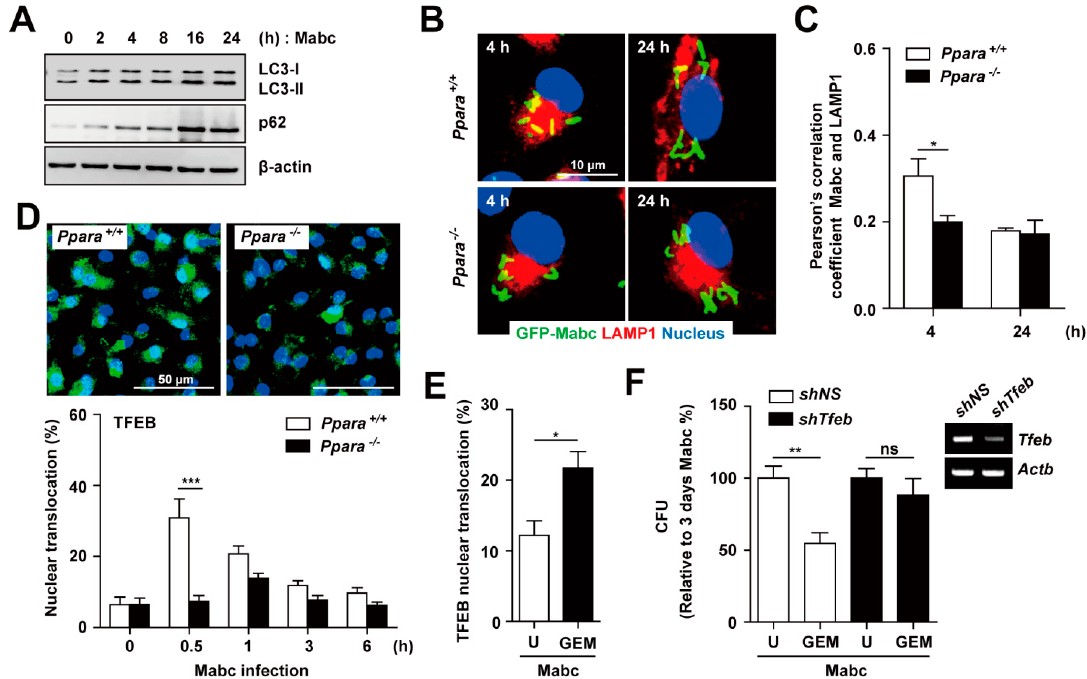
Figure 6. PPAR α activation by GEM enhances TFEB-mediated antimicrobial activity. ( A ) BMDMs were infected with Mabc (MOI of 5) for the indicated times, and the p62, LC3, and β -actin protein levels were evaluated by immunoblotting ( B ) BMDMs were infected with GFP-Mabc (MOI of 5) for 4 or 24 h. Alexa-594-conjuated LAMP1 (red) and DAPI (nuclei; blue) were visualized by confocal microscopy. Scale bars, 10 µ m. ( C ) GFP-Mabc and LAMP1 colocalization was assessed by calculating Pearson’s correlation coe ffi cient. ( D ) Ppara +/+ and Ppara - / - BMDMs were infected with Mabc (MOI of 5) for the indicated times, and nuclear translocation of TFEB was assessed by confocal microscopy. (Top) Representative images. Scale bar, 50 µ m. (Bottom) Quantitative analysis of TFEB nuclear translocation. ( E ) BMDMs were infected with Mabc (MOI of 5) for 3 h and treated with gemfibrozil (GEM; 100 µ M). Nuclear translocation of TFEB was assessed by confocal microscopy and calculated quantitative analysis. ( F ) BMDMs were transduced with lentivirus expressing a nonspecific shRNA (sh NS ) or shRNA targeting Tfeb (sh Tfeb ) using polybrene (8 mg / mL). After 36 h, BMDMs were